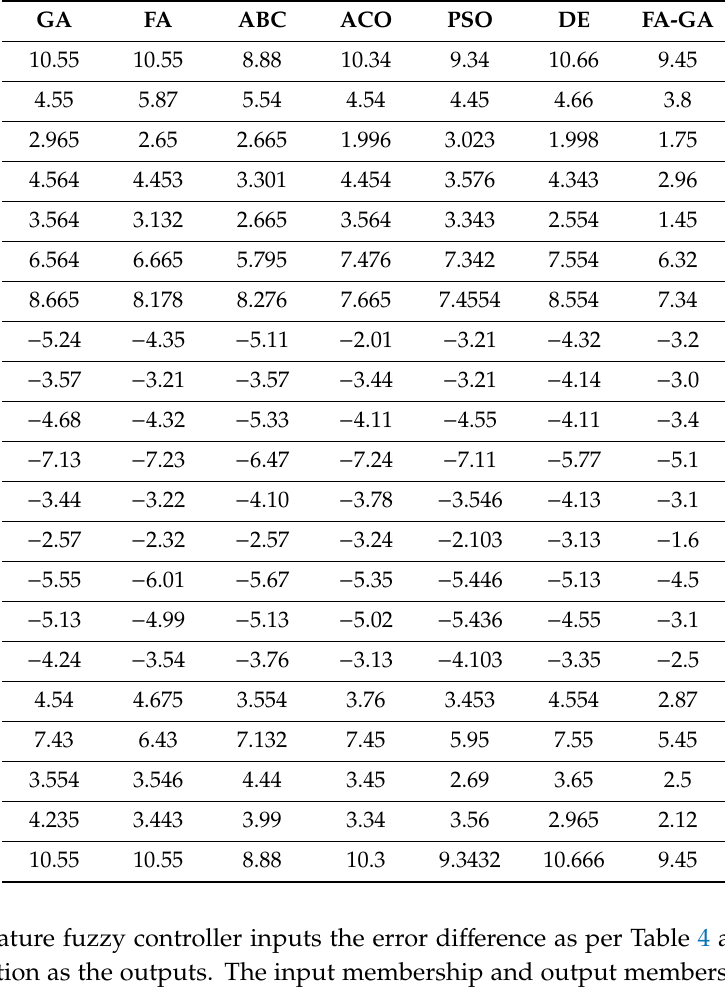
Figure 5. Temperature fuzzy controller outputs. An example of the input and output for the temperature fuzzy controller is given in Figures 5 and 6, which show the complete inputs–outputs relationship for the temperature fuzzy controller. Balancing the relationship between inputs and outputs for the temperature fuzzy controller results in the most optimal solution.